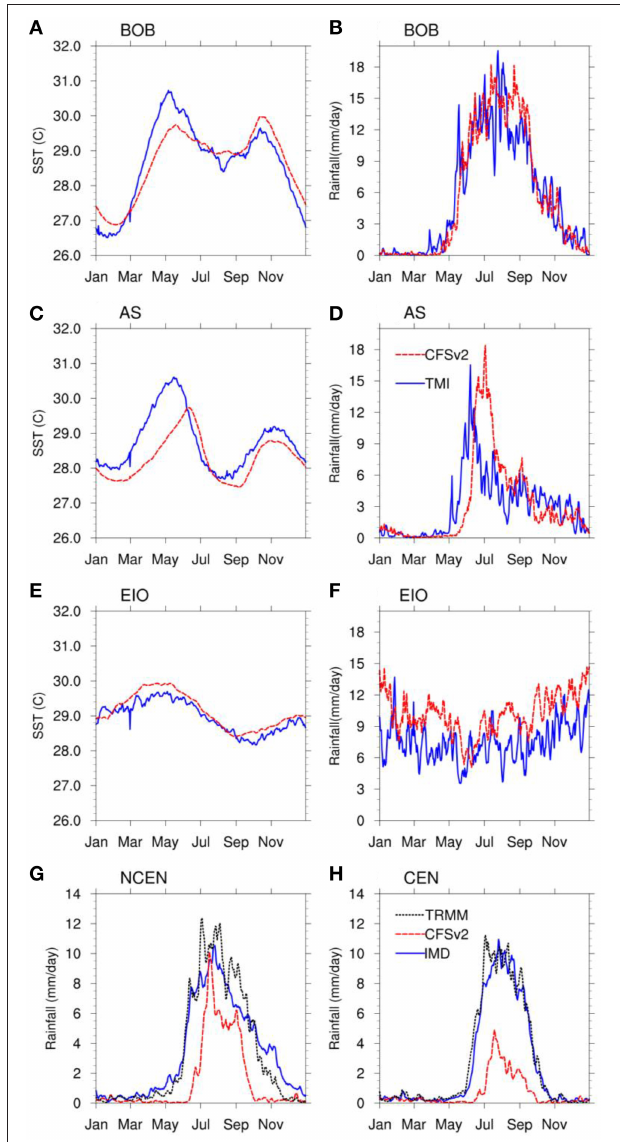
FIGURE 3 | Annual cycle of SST ( A,C , and E ) from observations (blue solid line) and CFSv2 model simulations (red dashed line) over three oceanic regions (A) Bay of Bengal (BoB) (12 ◦ –20 ◦ N, 85 ◦ –100 ◦ E); (C) Arabian Sea (AS) (12 ◦ –20 ◦ N; 60–75 ◦ E), and (E) Equatorial Indian Ocean (EIO) (5 ◦ S–10 ◦ N, 85 ◦ –100 ◦ E) and rainfall ( B,D , and F ). Annual cycle of rainfall over Indian land regions, NCEN (15 ◦ –25 ◦ N, 72 ◦ –85 ◦ E) and CEN (21 ◦ –27 ◦ N, 72 ◦ –85 ◦ E) and in (G,H) observed annual cycle over land regions from TRMM is also included.